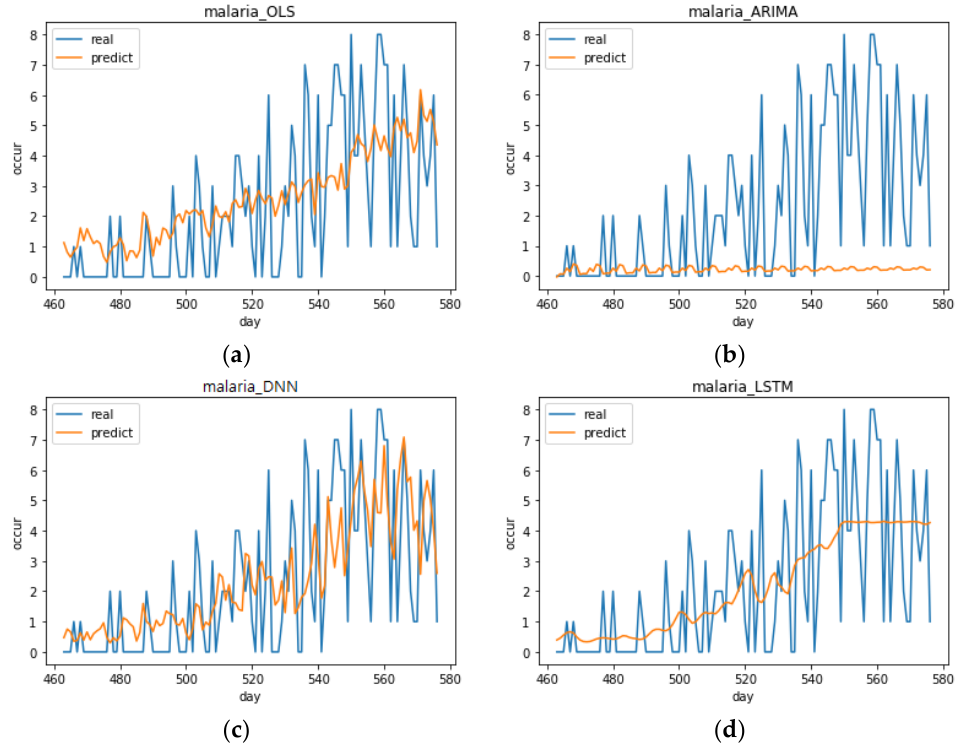
Figure 9. Top performing malaria predictions for each analysis method. ( a ) Prediction graph of OLS model in malaria, ( b ) Prediction graph of ARIMA model in malaria, ( c ) Prediction graph of DNN (4, 4, 3) model with the best performance in malaria, ( d ) Prediction graph of LSTM (1, 4, 3) model with the best performance in malaria.